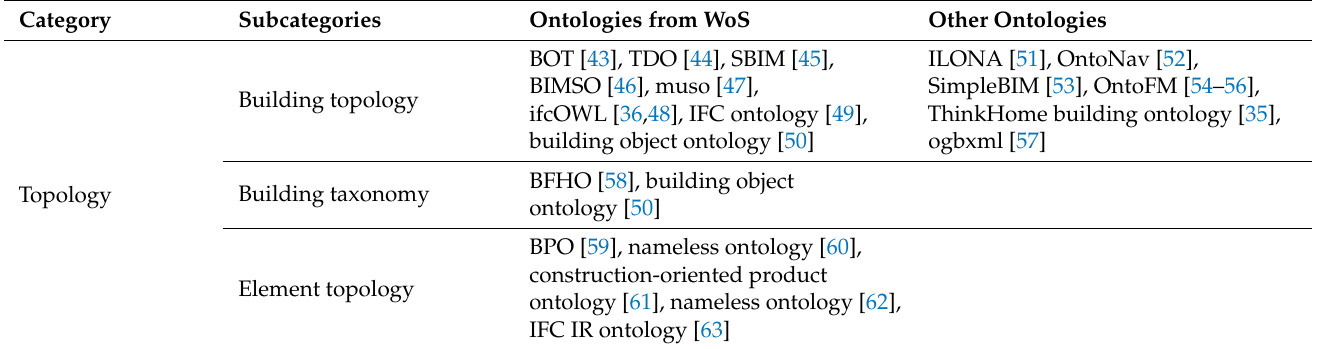
Table 2. Key data categories and the corresponding